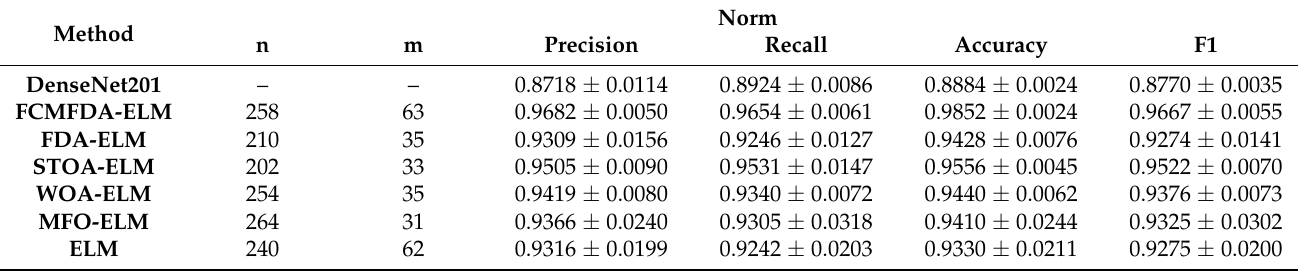
Table 10. Indicators of each algorithm